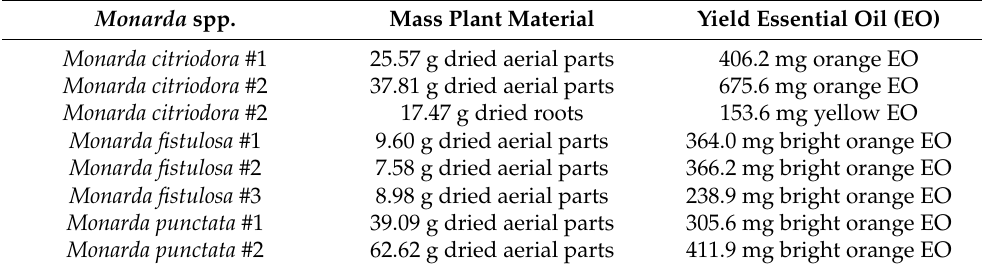
Table 5. Hydrodistillation details of Monarda species collected or cultivated in south Alabama. Monarda